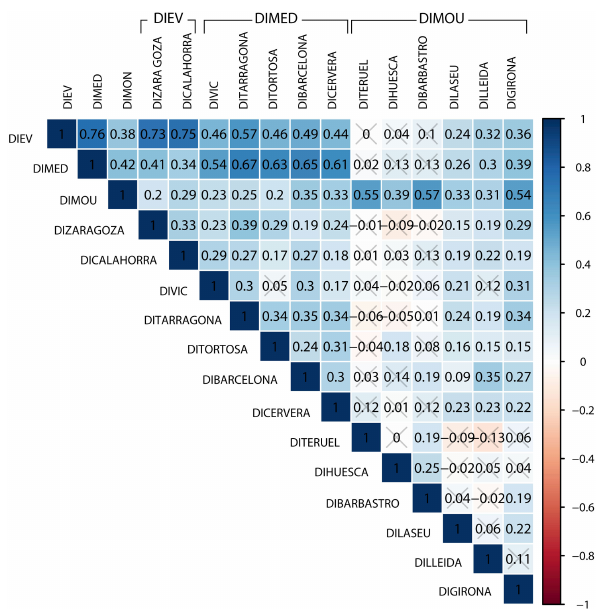
Figure 4. Correlation matrix (Spearman) between the individual drought indices and the cluster drought indices for the period of 1650–1899. Values are significant at p <0.05, except those marked with a gray cross, which are not